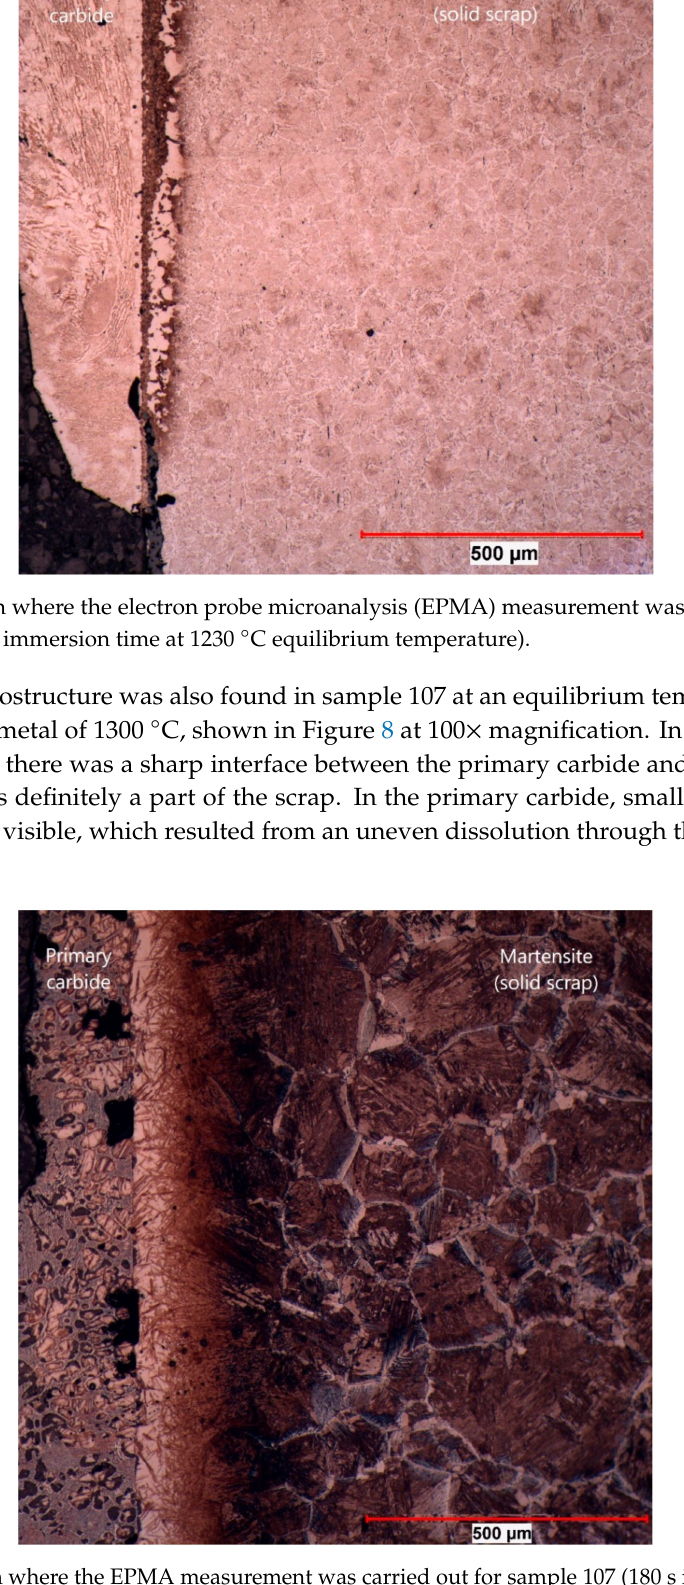
Figure 8. Section where the EPMA measurement was carried out for sample 107 (180 s immersion time at 1300 ◦ C equilibrium